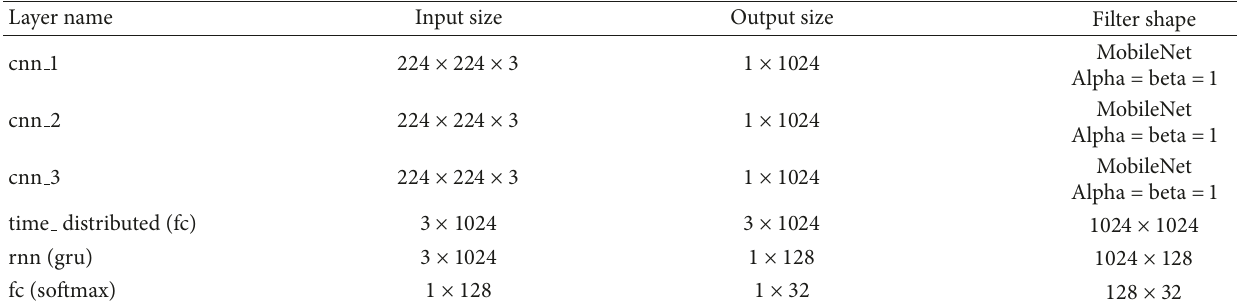
Table 1: C-RNN architecture.